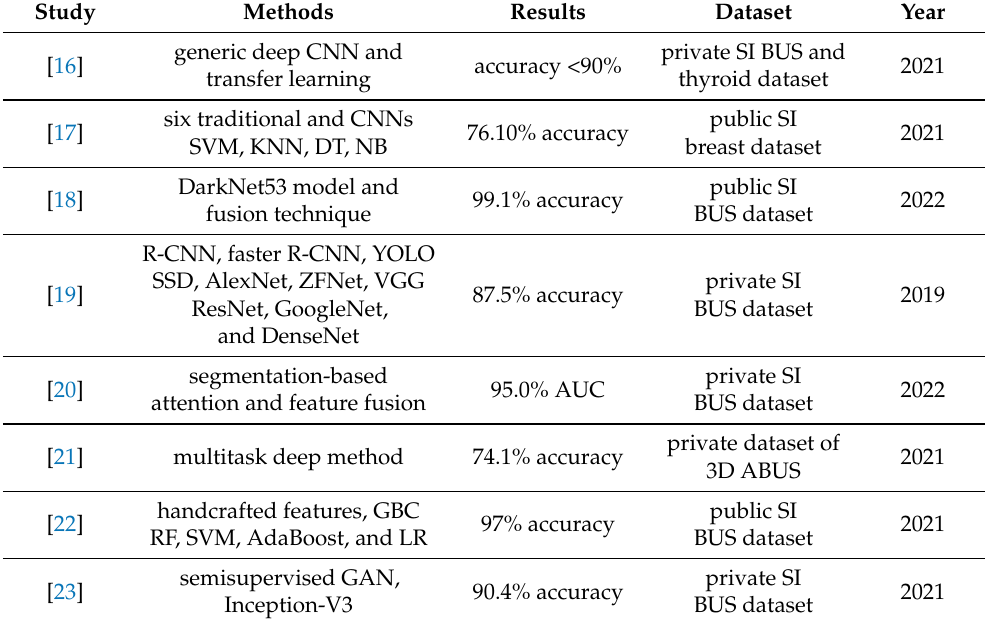
Table 1. Summary of research for the diagnosis of breast cancer based on ultrasound images. Study Methods Results